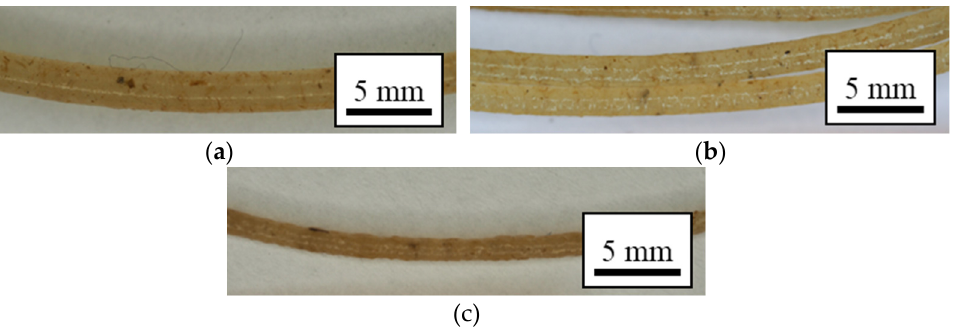
Figure 3. Representative images of the extruded filaments of the 3 mm group: ( a ) 2 wt.%, ( b ) 3.5 wt.%, and ( c ) 5 wt.%.